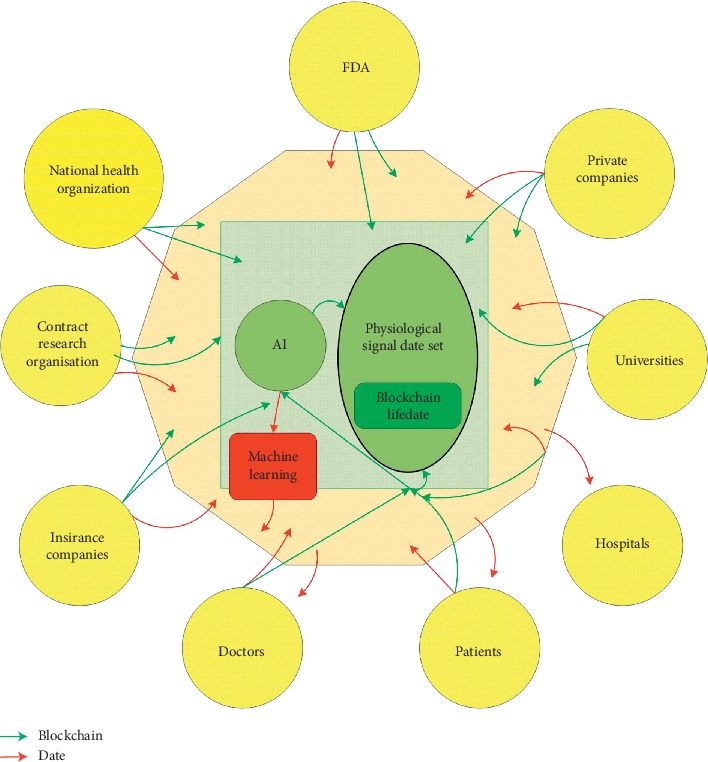
The flow of data from the individuals to the companies and research institutions.